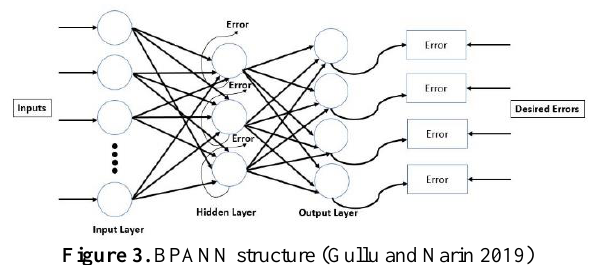
Figure 3. BPANN structure (Gullu and Narin 2019)